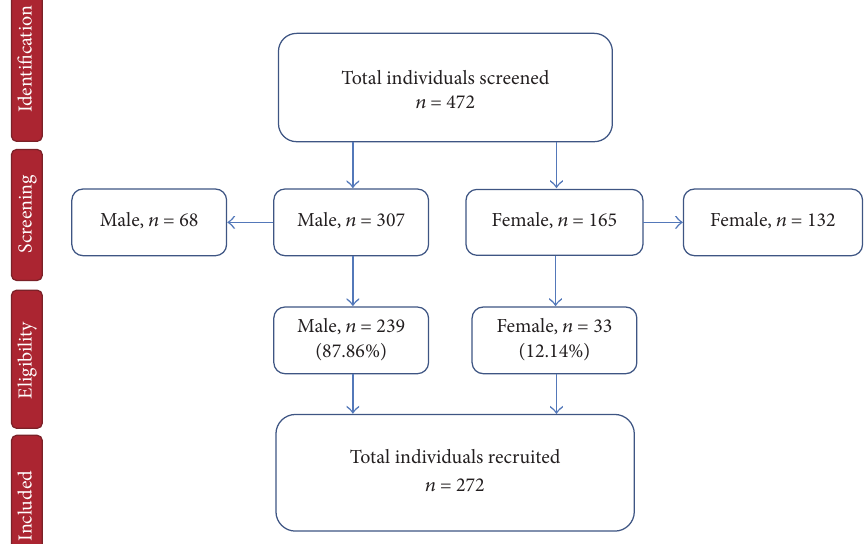
Figure 1: Study profile of the individuals recruited in the cross-sectional survey in Tanga region.